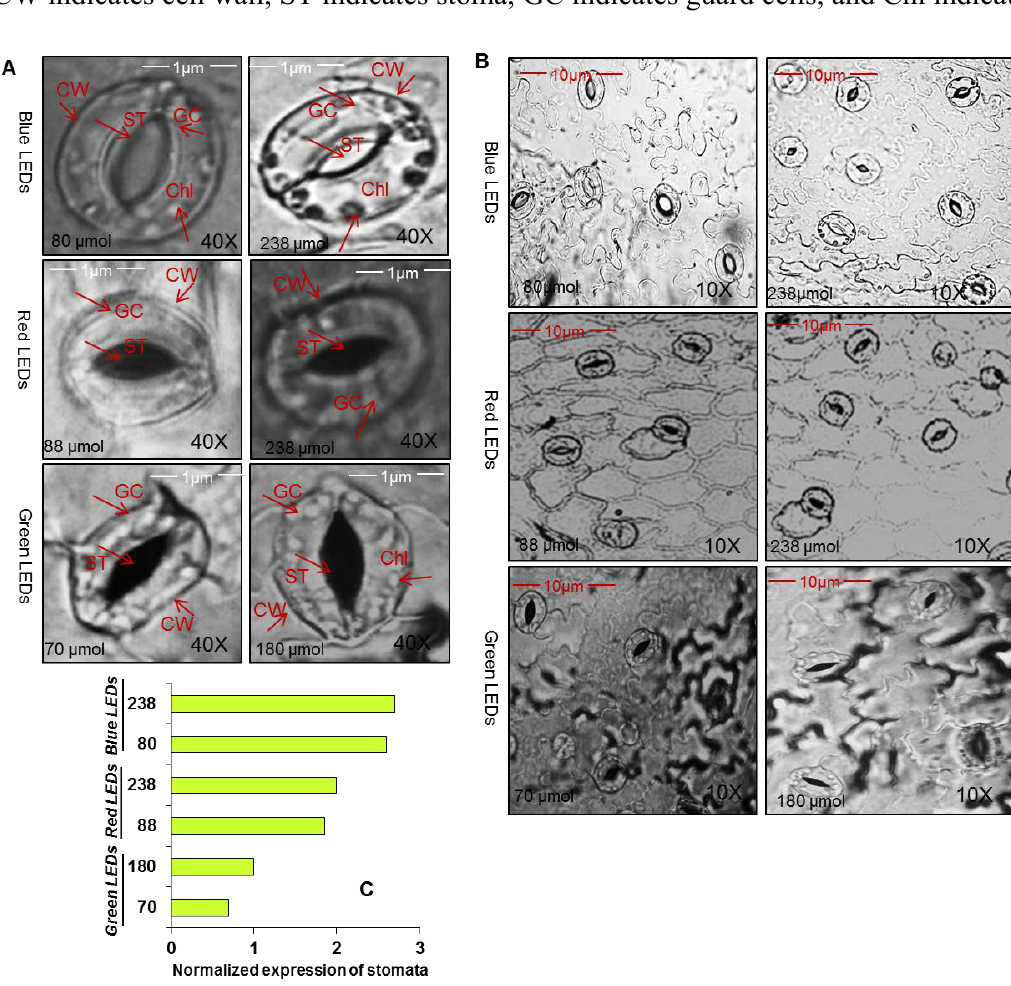
Figure 3. ( A , B ) Representative images; and ( C ) Normalized expression of stomata as affected by green, red and blue LEDs at different light intensities green (70 and 180 μmol m −1 s −1 ), red (88 and 238 μmol m −1 s −1 ) and blue (80 and 238 μmol m −1 s −1 ). Thin layer of leaf outer covering were peeled off carefully and laid on a glass slide, covered with a cover slip and were observed under a light microscope (Leica CME) at 40× magnification. CW indicates cell wall, ST indicates stoma, GC indicates guard cells, and Chl indicates